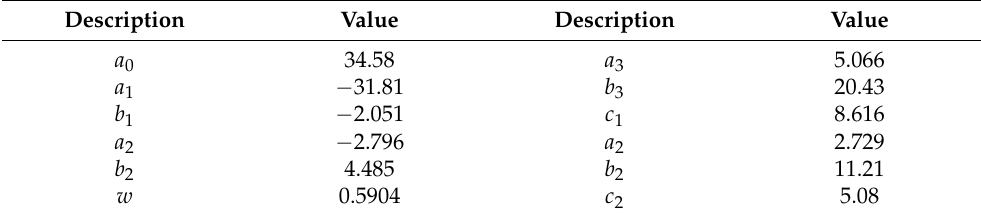
Table 1. Parameters of the respective function coefficients of SMA passive tensile and active shrinkage data. Description Value